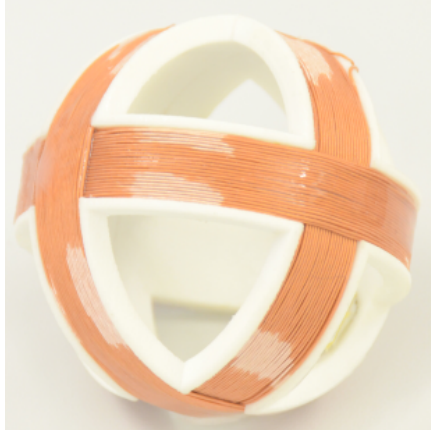
Figure 2. 3-D coil with three passive resonantly tuned individual